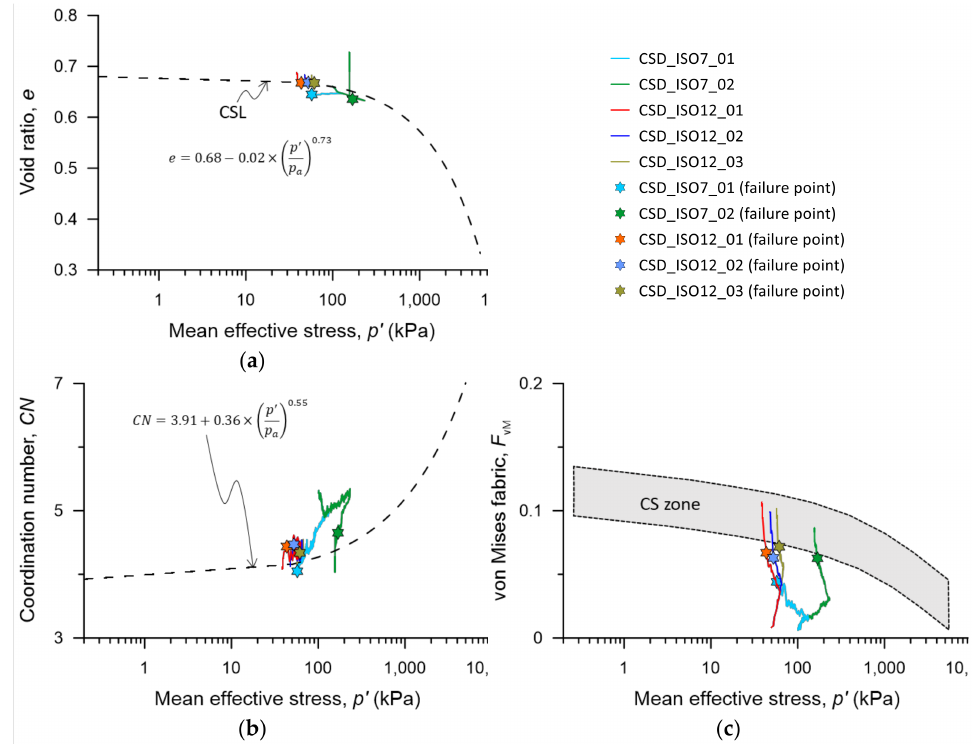
Figure 9. The evolution of macro- and micro-mechanical entities during CSD simulations in ( a ) e - log( p (cid:48) ), ( b ) CN -log( p (cid:48) ) and ( c ) F vM -log( p (cid:48) ) spaces.